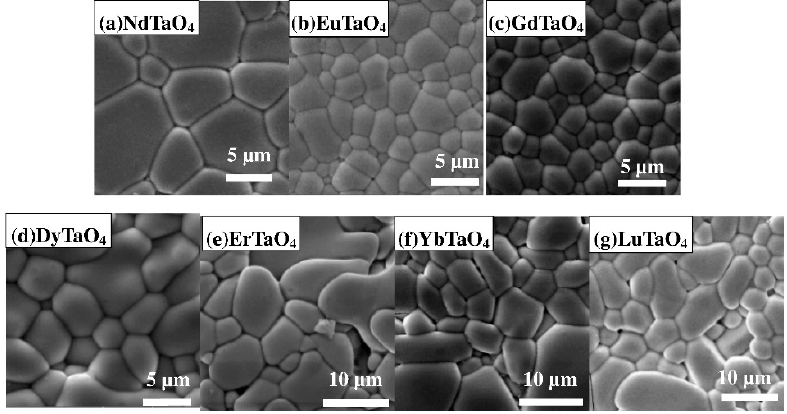
Figure 37. SEM photographs of RETaO 4 (RE = Nd, Eu, Gd, Dy, Er, Yb, Lu) ceramics [194]